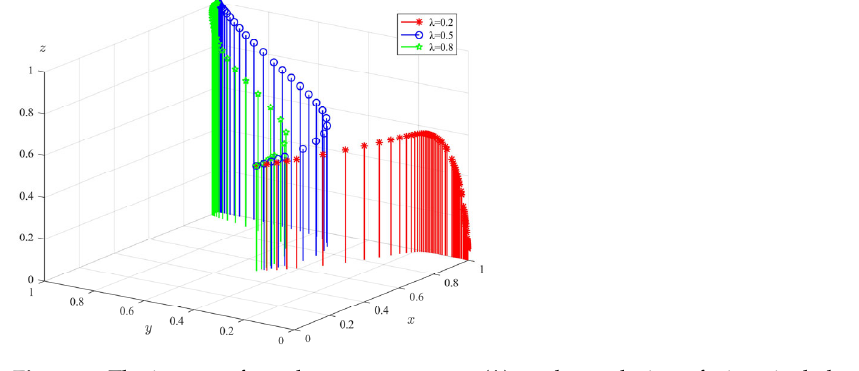
Figure 6. The impact of regulatory success rate ( λ ) on the evolution of tripartite behavior.